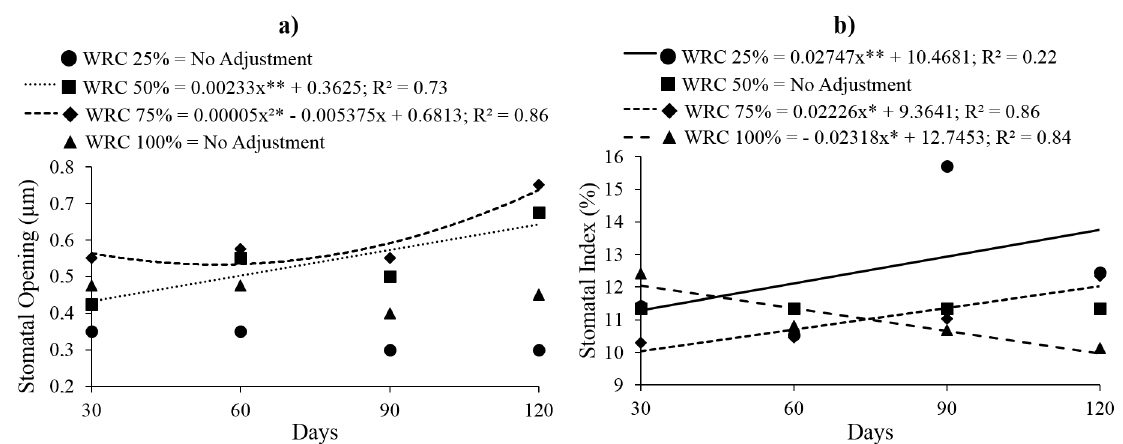
Figure 4 - Stomatal opening ( a ) and stomatal index ( b ) in Copaifera langsdorffii Desf. depending on different water retention capacity (WRC) and